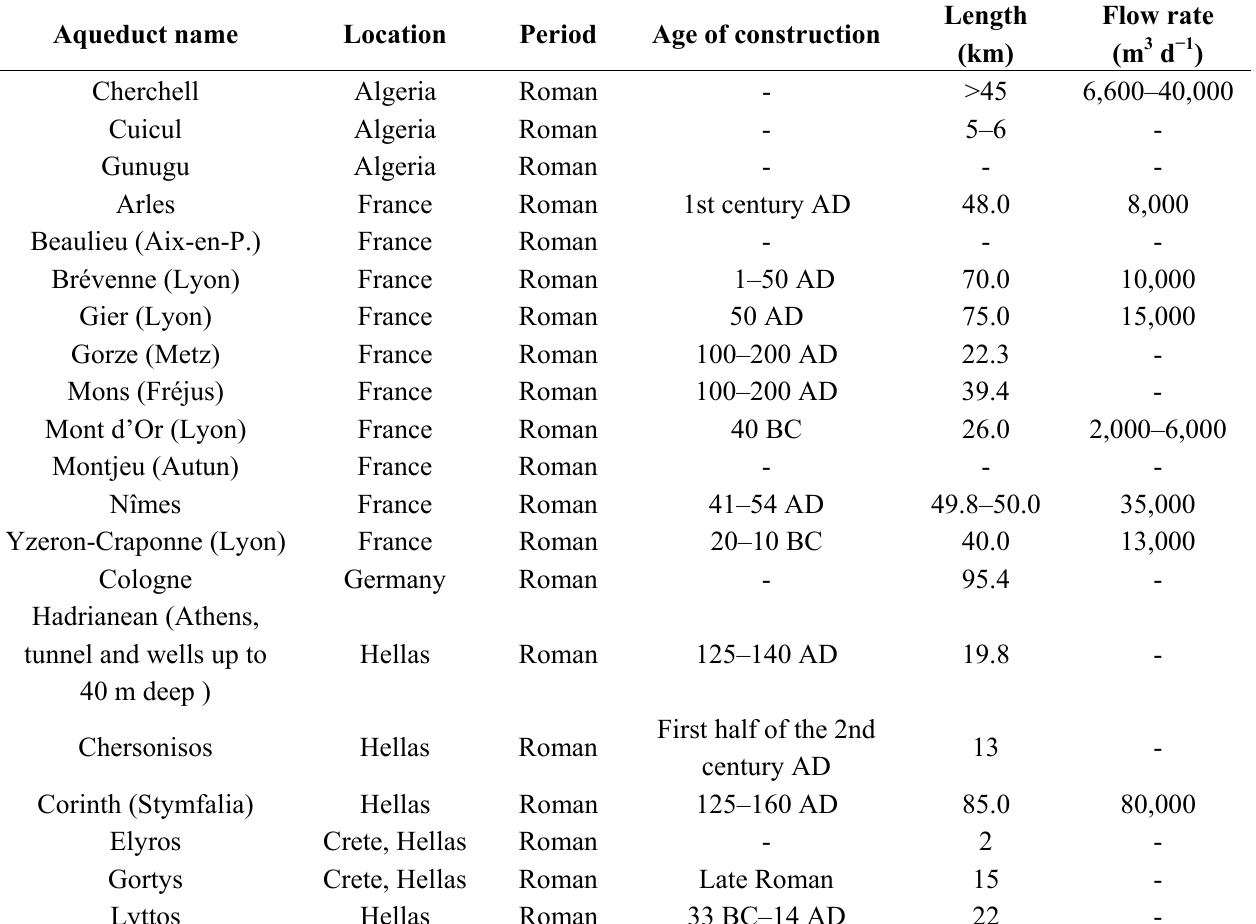
Table 4. Characteristics of a selection of Roman aqueducts (adapted from De Feo et al. [44], Kessener and Piras [51], Chiotis and Marinos [64], Haut and Viviers [65], Ortloff and Crouch